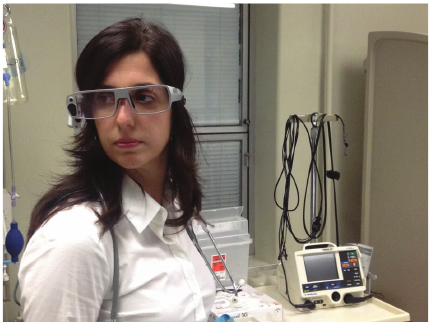
Figure 1: Study participant wearing portable gaze-tracking glasses.